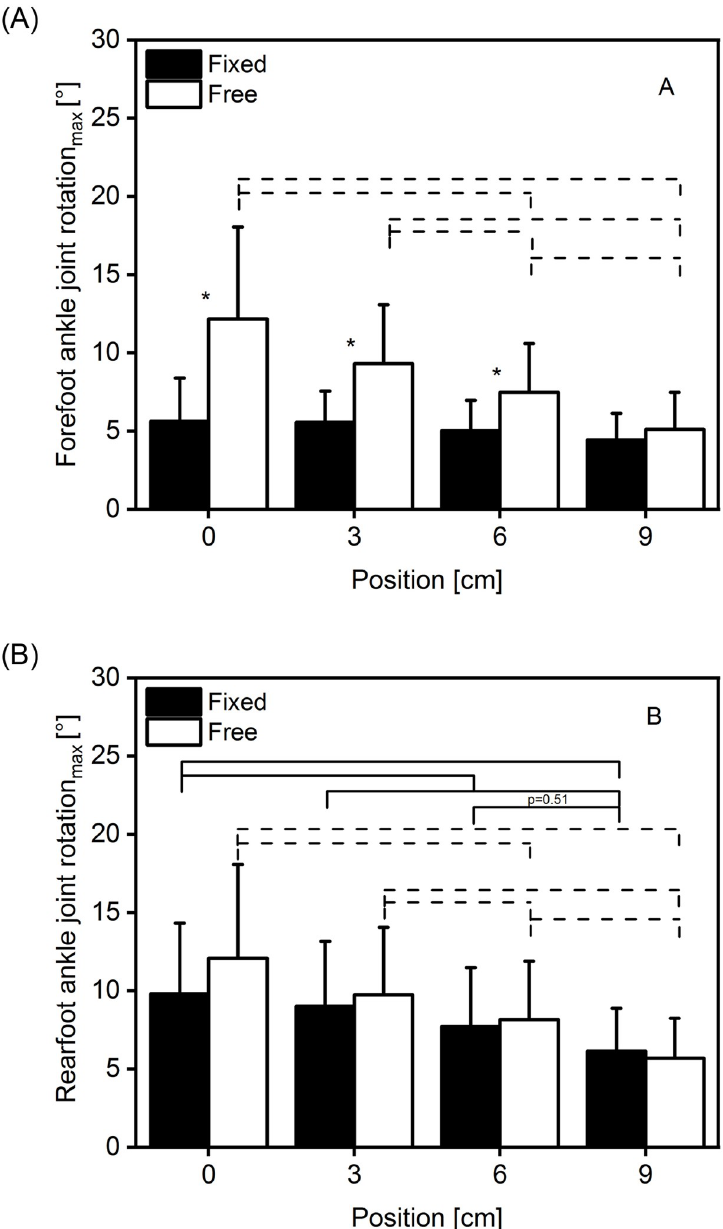
Fig 3. Maximal ankle joint rotation at four positions, two conditions and two measuring sites. Forefoot (A) and rearfoot (B) average ( ± SD) maximal ankle joint rotation during plantarflexion in fixed (filled bars) and free (empty bars) condition, at four (0–9 cm) positions (n = 14). Solid lines indicating significant difference (p < 0.05) between positions at fixed condition, and dashed lines indicating significant difference between positions at free condition (p < 0.05). � : Indicating significant difference (p < 0.05) between conditions (n = 14). and the Hip-Joint-Angle at rest (Table 1) indicating similar initial test-conditions. The Hip- Joint-Angle at max showed, at position 0 cm, significant differences from the positions 3–9 cm at both conditions (Table 1). Additionally, the foot pressure increased significantly from 0 to 9 cm (Table 1).